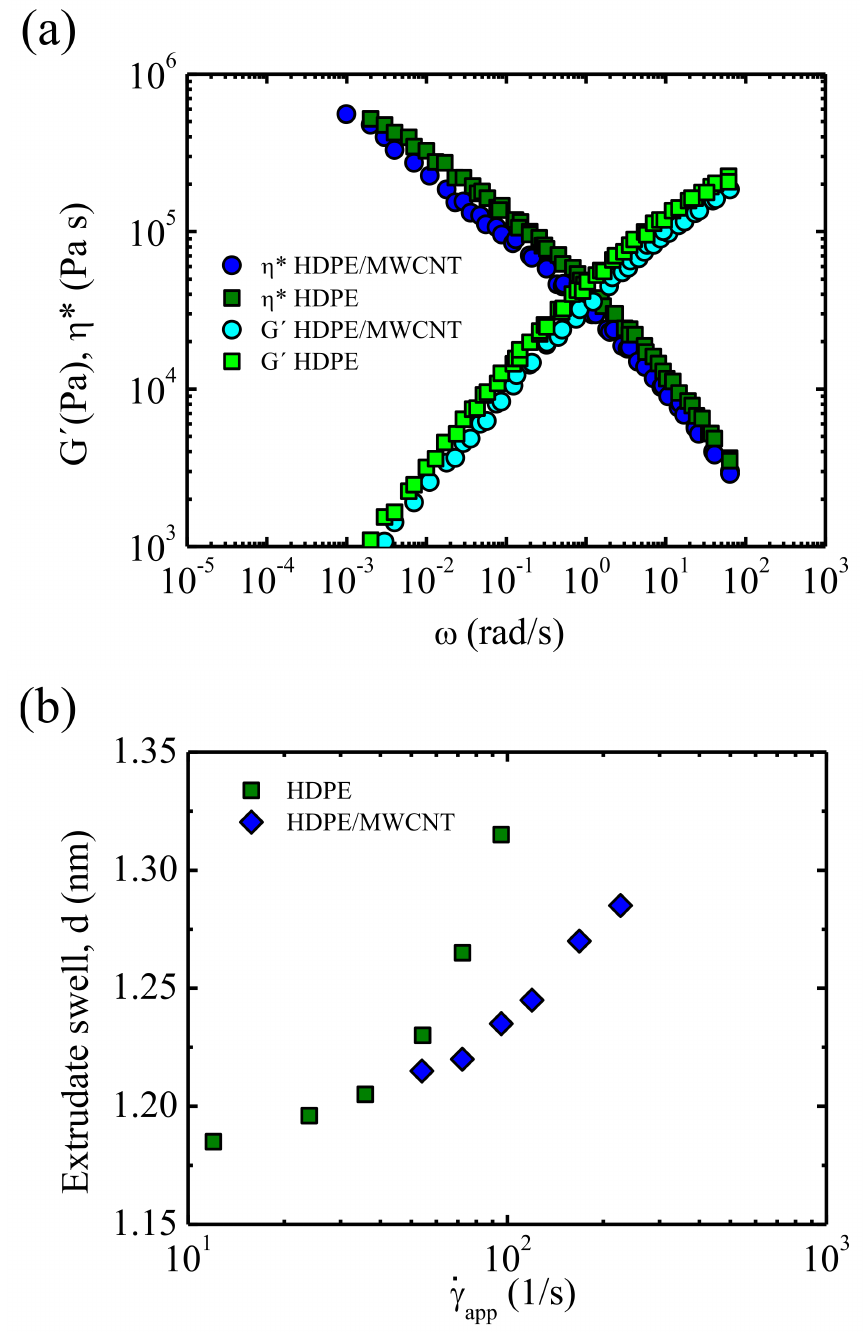
Figure 10. ( a ) Storage modulus and complex viscosity as a function of frequency for neat HDPE and HDPE/MWCNT. ( b ) Extrudate swell as a function of apparent shear rate for neat HDPE and HDPE/MWCNT nanocomposite [158] Reprinted with permission from [158] Copyright 2009 American Chemical